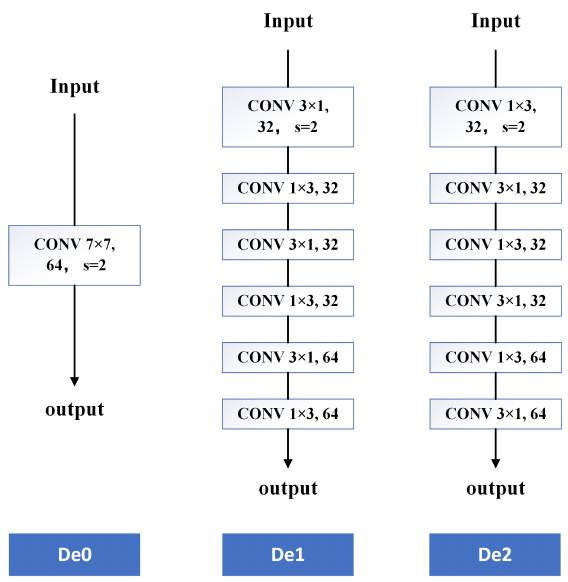
Figure 5. Structure of De1 and